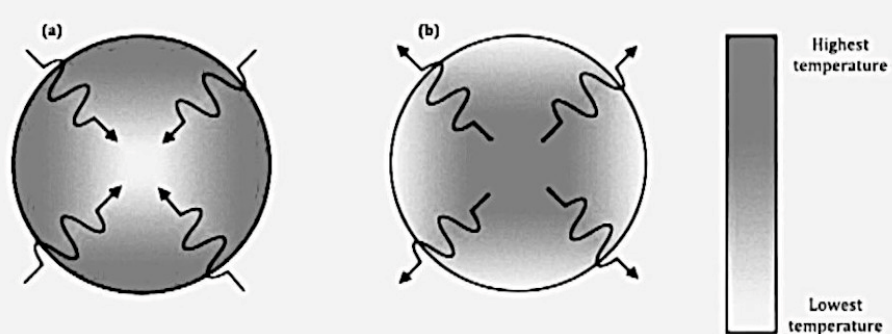
Figure 3. Heating profiles in ( a ) conventional, ( b ) microwave [33].